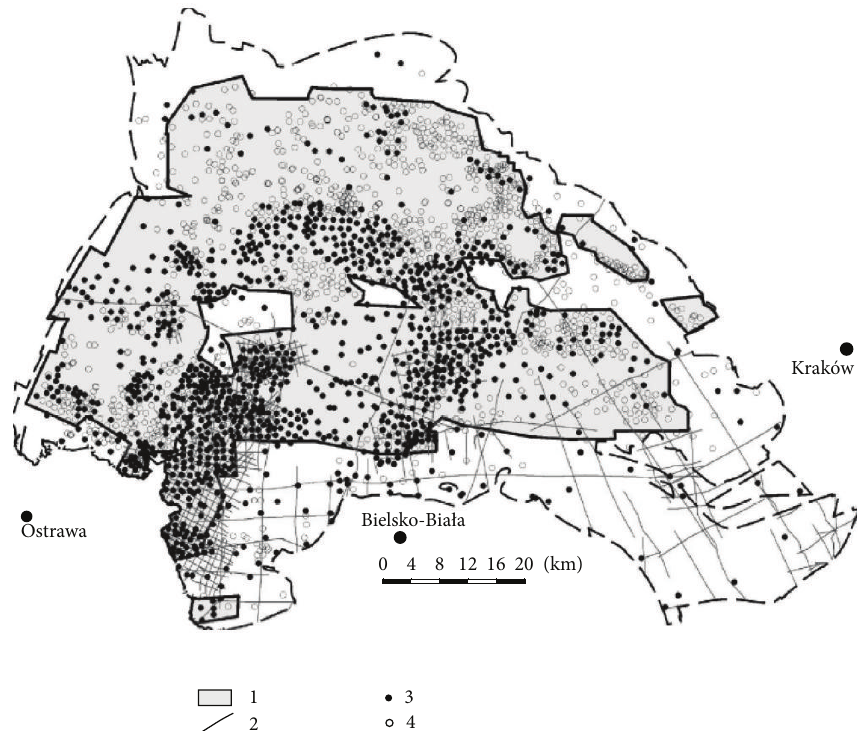
Figure 1: Geological exploration of the Upper Silesian Coal basin 1—documented area, 2—seismic profiles, 3—wells of the depth of at least 1,000 m, and 4—wells of a depth of 500–1,000 m